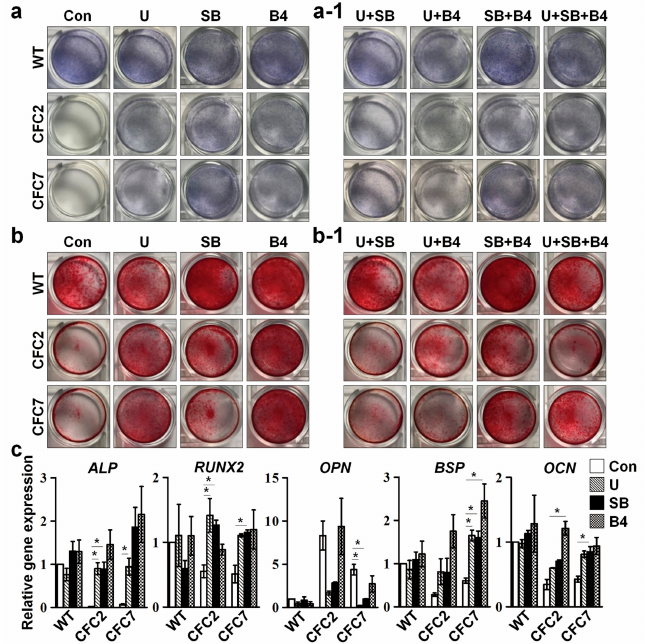
Figure 6. Rescue of defective osteogenesis in CFC-MSCs through regulation of ERK, SMAD2, and SMAD1 signaling pathways. ALP activity ( a ) and calcium deposition ( b ) were enhanced in CFC-MSCs during osteogenic differentiation upon treatments with an ERK signaling inhibitor (U), SMAD2 pathway inhibitor (SB), and a SMAD1 pathway agonist (B4). However, combined treatments with respective signaling regulators had no additional effects in ALP activity ( a-1 ) and mineral deposition ( b-1 ); ( c ) Increased expression of osteogenic genes in CFC-MSCs during osteogenic differentiation after treatments with U, SB, and B4. Data were expressed as the mean ± SEM (n = 3, biological replicate). * p <